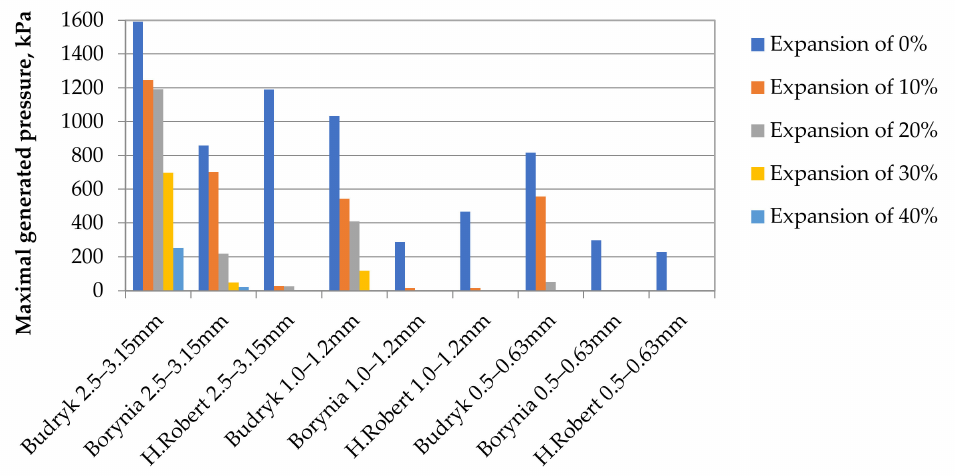
Figure 6. Impact of grain size of the examined coal samples on the generated coking